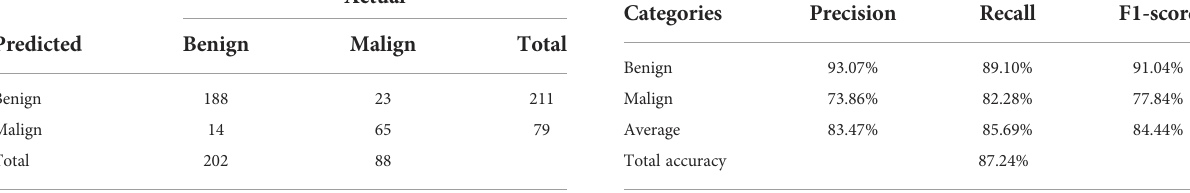
TABLE 6 Confusion matrix of the proposed model on the unbalanced data set.